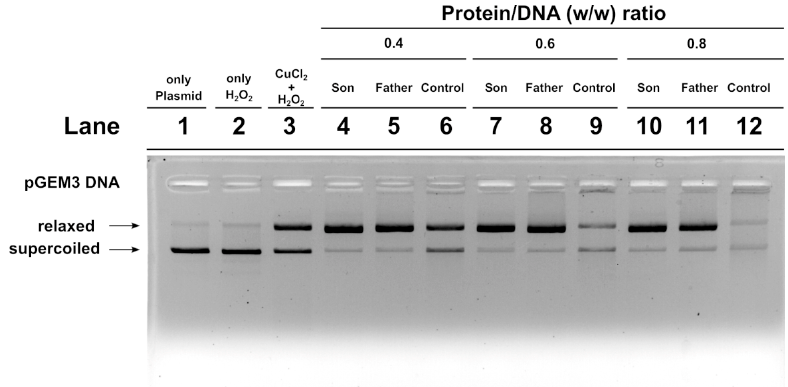
Figure 6. DNA protection analysis on 1% agarose gel of pGEM3 plasmid DNA in the presence of increasing (0.4, 0.6 and 0.8) controls (lanes 6, 9 and 12), son (lanes 4, 7 and 10) and father (5, 8 and 11) SNBP/DNA ratios. SNBP: sperm nuclear basic